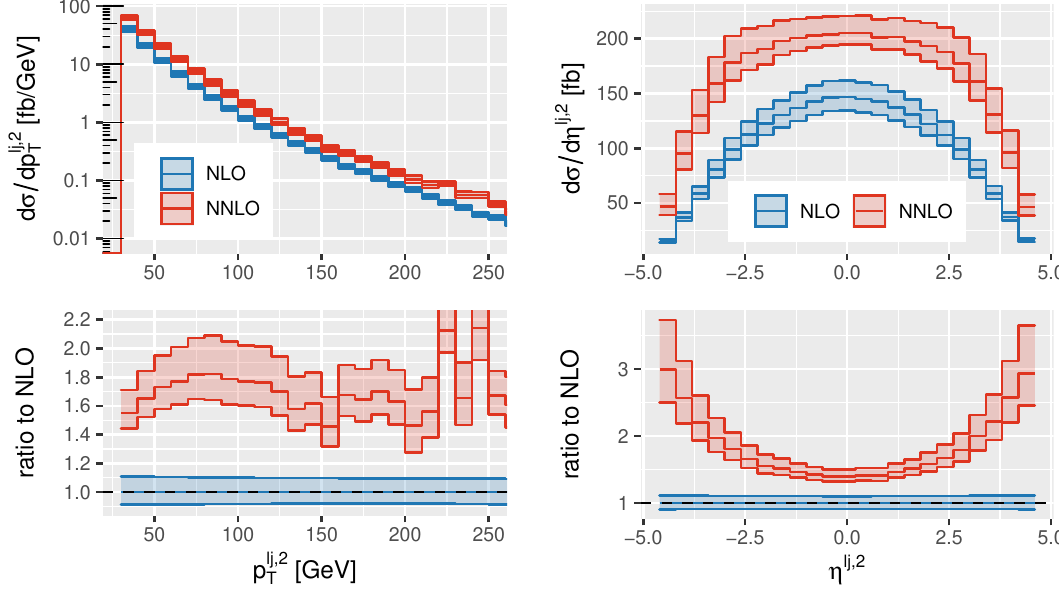
Figure 14 . p T -subleading light jet transverse momentum distribution (left) and pseudorapidity distribution (right).